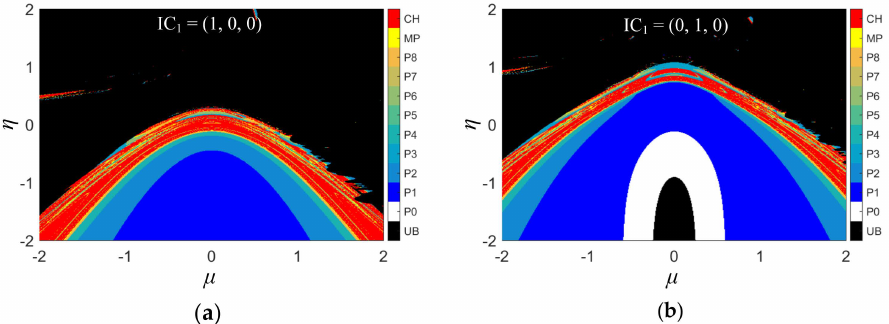
Figure 7. Local basins of attraction in the µ – η plane for two sets of large non-memristor initial conditions IC 1 = ( x 1 (0), x 2 (0), x 3 (0)): ( a ) IC 1 = (1, 0, 0), and ( b ) IC 1 = (0, 1,